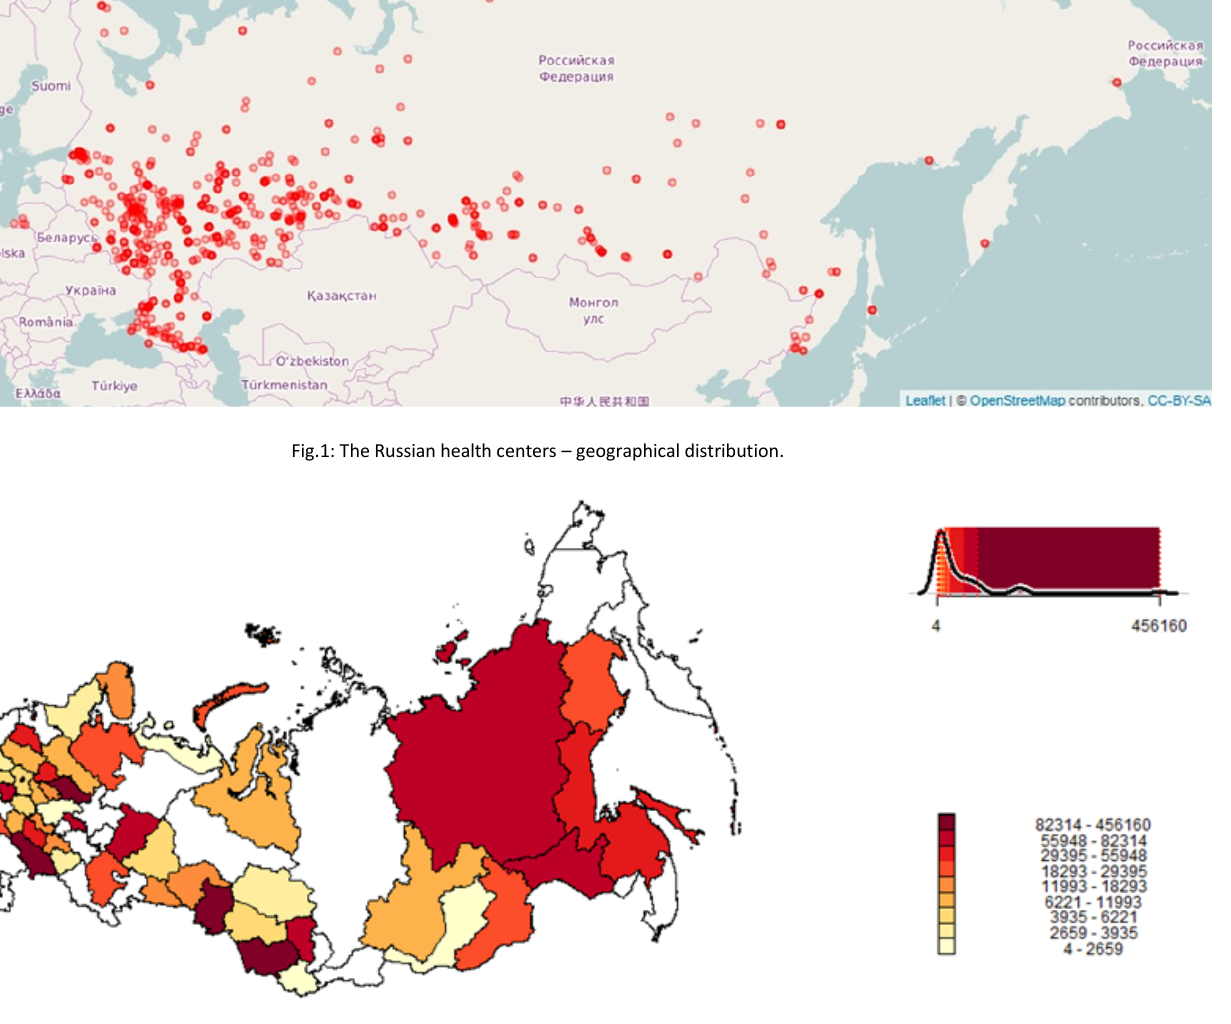
Fig.2: Frequency distribution of the BIA records (n=2,429,977) by the Federal subjects of